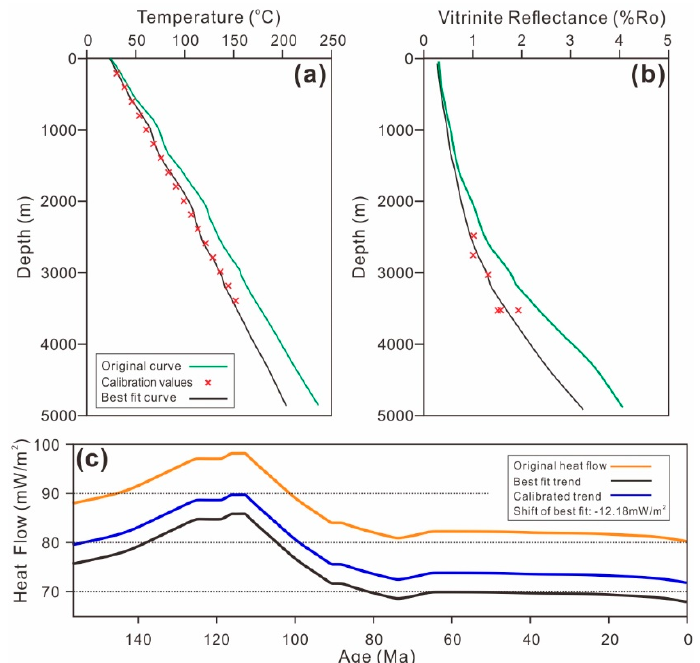
Figure 11. Results of HF calibration (Well TS6). ( a ) Single well temperature simulation result using original HF (green curve) and the best-fit HF (black curve), calibrated by bore-hole temperatures (red crosses). ( b ) Single-well vitrinite reflectance (VR) simulation result using original HF and best-fit HF, calibrated by measured Ro (red crosses). ( c ) Optimized HF among the original HF, best-fit trend and calibrated trend after implementing the map-smoothing method.